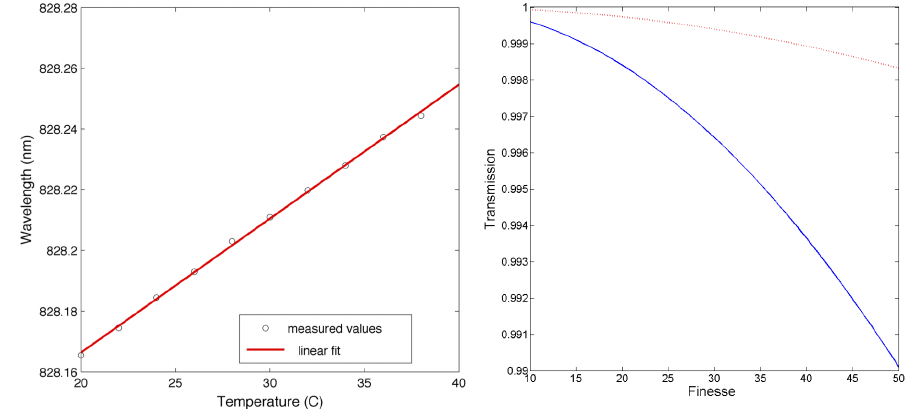
Figure 3. Etalon temperature tuning and stability. Left panel: resonant wavelength as a function of etalon operating temperature. The black circles represent measured values while the red line is a linear fit yielding a temperature tuning rate of 0.0041nm ◦ C − 1 . Right panel: the cavity transmission as a function of finesse for a locking stability of 0.0002nm (solid blue line) and a temperature stability of 0.01 ◦ C (dotted red line).